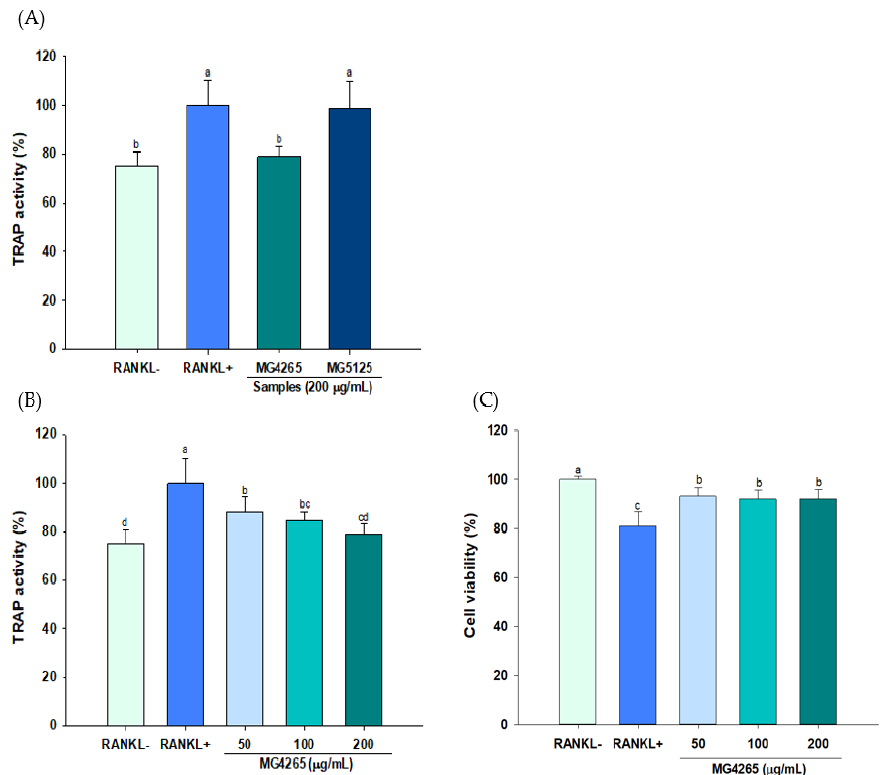
Figure 3. Effect of SCS produced from L. salivarius MG4265 and L. lactis MG5125 on ( A ) Tartrate- resistant acid phosphatase-positive (TRAP) activity, ( B ) concentration dependent effect, and ( C ) cell viability in nuclear factor κB ligand (RANKL) stimulated RAW 264.7 macrophages. Different letters (a–d) indicate significant difference at p < 0.05.